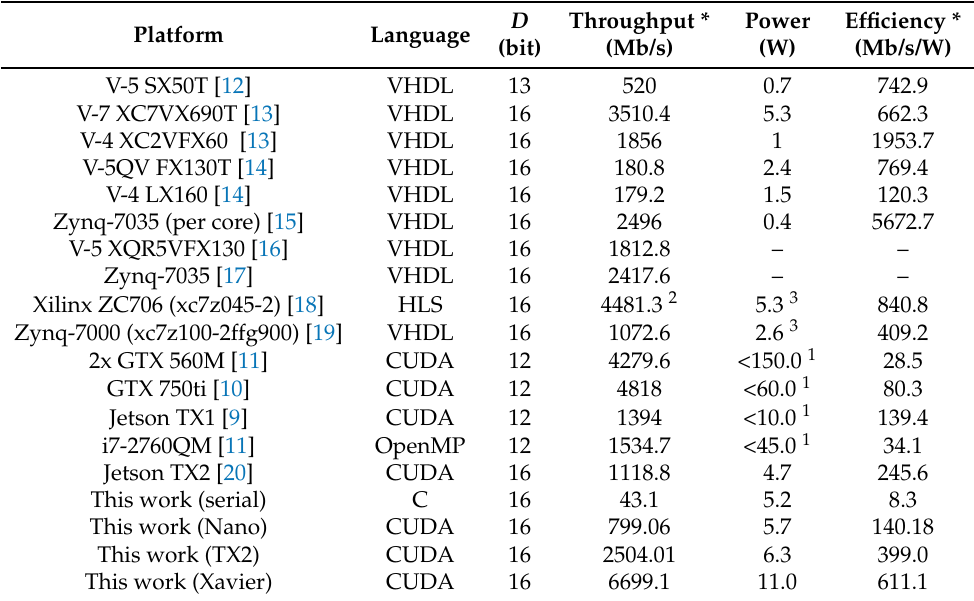
Table 7. Surveyed CCSDS-123 parallel implementations on field-programmable gate arrays (FPGAs), GPUs and CPUs. * Higher is better. Platform